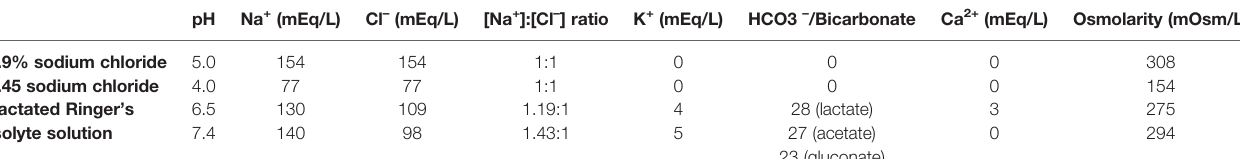
TABLE 2 | Composition of common crystalloid IV fl